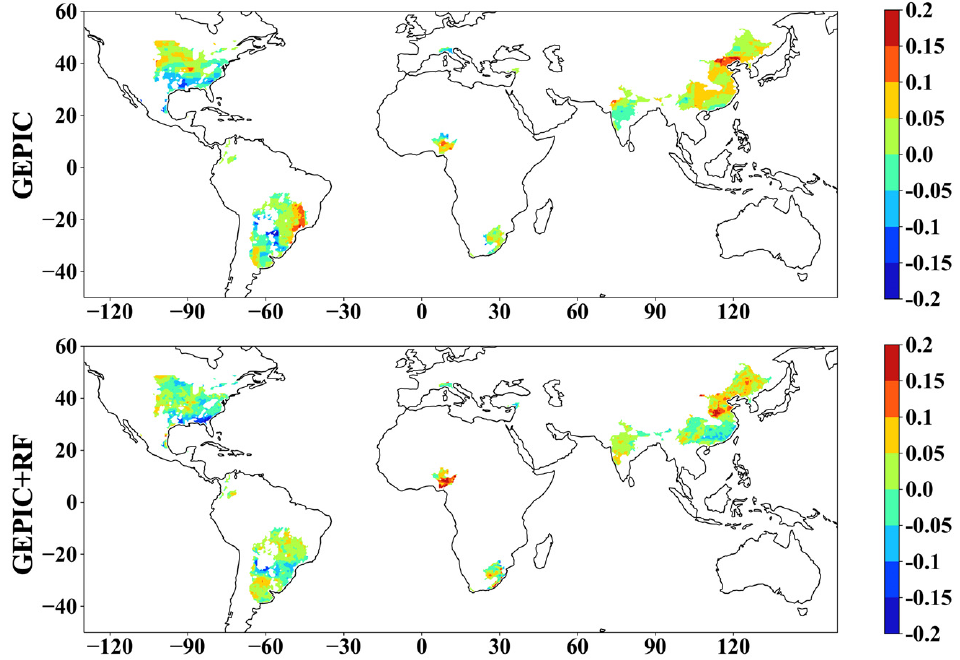
Figure 8. Soybean yield change trends from 2040 to 2099 (t/ha/10a). From the importance analysis results (Figure 5), the changes of main extreme climate indicators during soybean growing season in the future are analyzed (Figure 9). The Tmin has an increasing trend at global scale and has a more than 0.3 ◦ C/10a trend in the central-south USA, northern Argentina and southern Brazil. The D8 has a decreasing trend in high latitude areas in the central-north USA, northeastern China and northern Argentina. Drought has an increasing trend in the central-south and eastern USA, southern Brazil, northern Argentina, Nigeria, and southwestern China, while it has a significant decreasing trend in central India and Brazil. The combined drought–heat disaster, Dt, tends to increase in most regions in all of the main producing countries. Moreover, the values of Dt have an obvious increase trend in southwestern and central China, the central